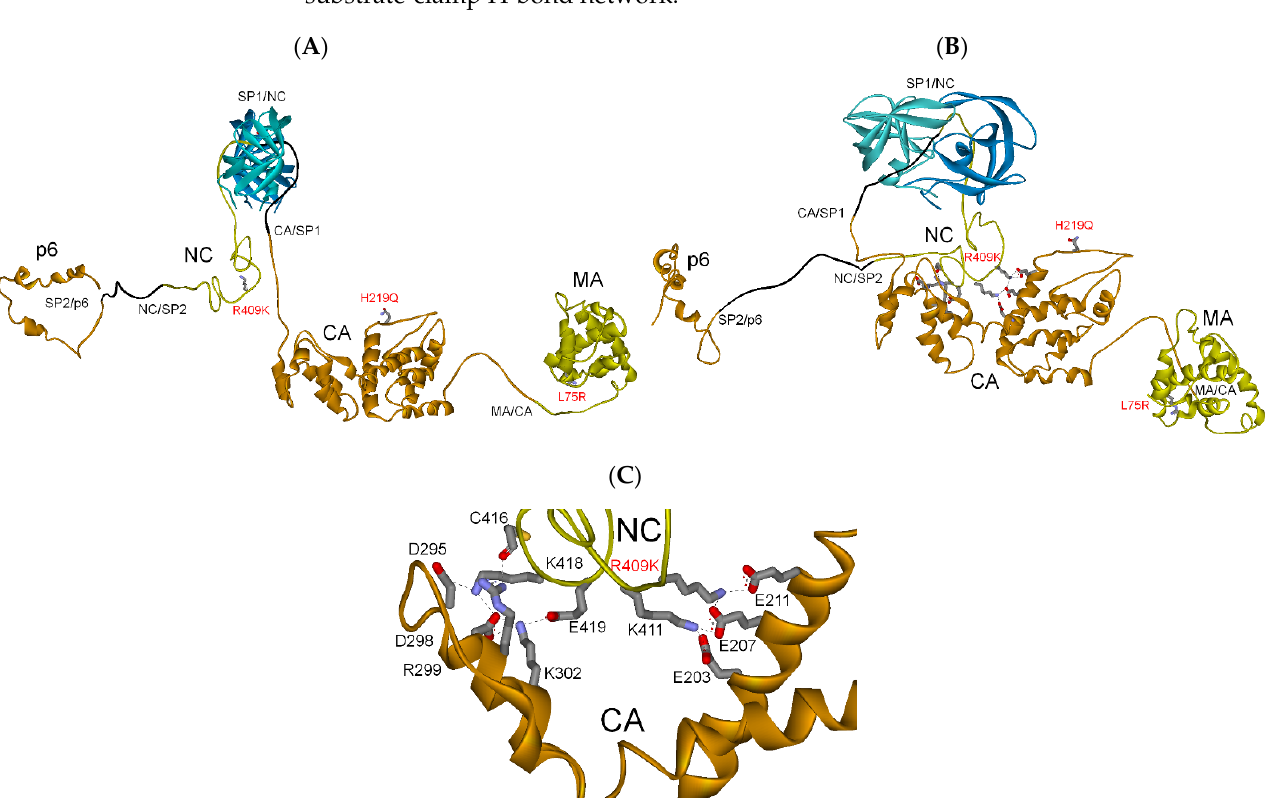
Figure 3. ( A ) HIV-1 PR (side-view, backbone ribbon, A-subunit teal, B-subunit blue) bound to the SP1/NC cleavage site in full-length Gag (backbone ribbon right-to-left, MA yellow, CA bronze, NC yellow, p6 bronze), with the SP1 and SP2 regions in black, the five cleavage sites indicated. Gag non-cleavage site PI resistance residues MA L75R, CA H219Q and NC R409K (red labels) shown (carbon grey, nitrogen blue); ( B ) HIV-1 PR (front view) bound to full-length Gag with a substrate-clamp formed between Gag CA and NC subdomains mediated by the Gag non-cleavage site PI resistance mutation NC R409K (red label), substrate-clamp H-bonding residues shown (carbon grey, oxygen red, nitrogen blue), Gag cleavage sites indicated as are PI resistance residues MA L75R and CA H219Q (red labels); ( C ), close-up view of the full-length Gag substrate-clamp interactions between CA and NC subdomain residues looking down and from the right side of B. Native CA residues (left side) D295, D298, R299, K302 and (right side) E203, E207, E211, and native NC residues (left side) C416, K418, E419, and (right side) K411 with the NC non-cleavage site PI resistant mutation R409K indicated with red label (upper center). H-bonds as dashed black lines, see Results and Discussion Section 3.2.1. for detailed description of the substrate-clamp H-bond